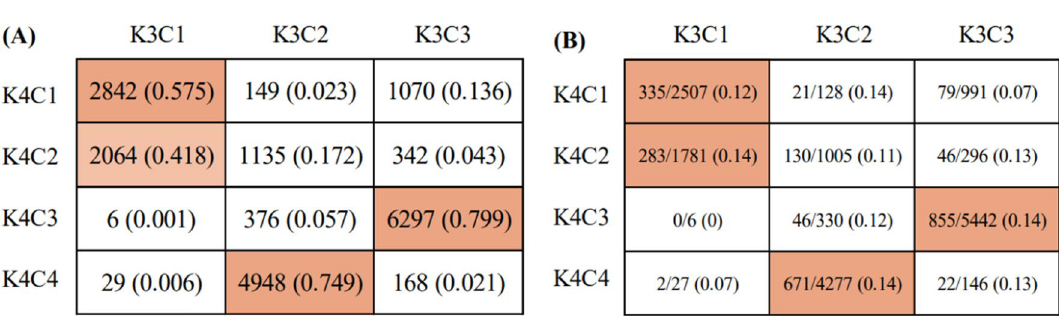
Figure 3. Comparison between three and four clusters established by K-means clustering. Colored rectangles indicate cases with prominently high number of common subjects between two subgroups. ( A ) Results are described number and column-based ratio for subjects including healthy control and sepsis patients in common between two subgroups. ( B ) Results are described as number of sepsis patients/healthy cases and ratio [sepsis patients/(sepsis + healthy